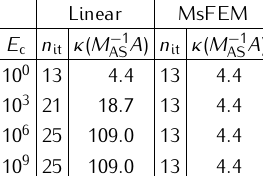
Young’s modulus Poisson ratio E ν . 2 mat = 1MPa mat = 0 E E E ν . 2 c inc = mat inc = 0